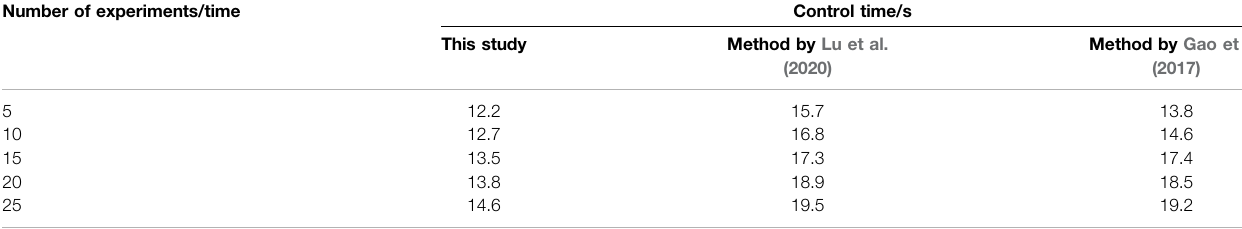
TABLE 2 | Comparison of results of safety risk management and control ef fi ciency of power trading institutions. Number of experiments/time